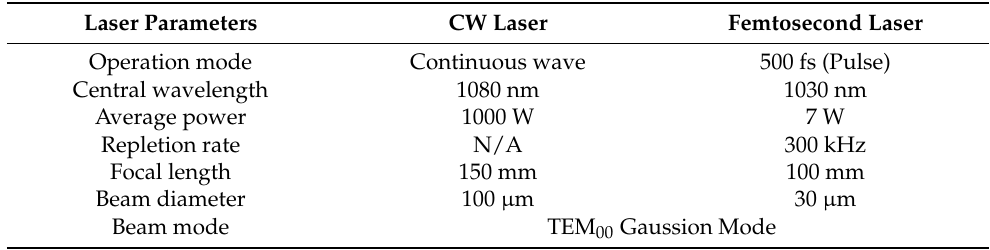
Figure 2. Experimental setup: ( a ) the first step: kilowatt fiber laser cutting; ( b ) the second step: femtosecond pulse laser cutting. Table 1. Main parameters of the lasers.